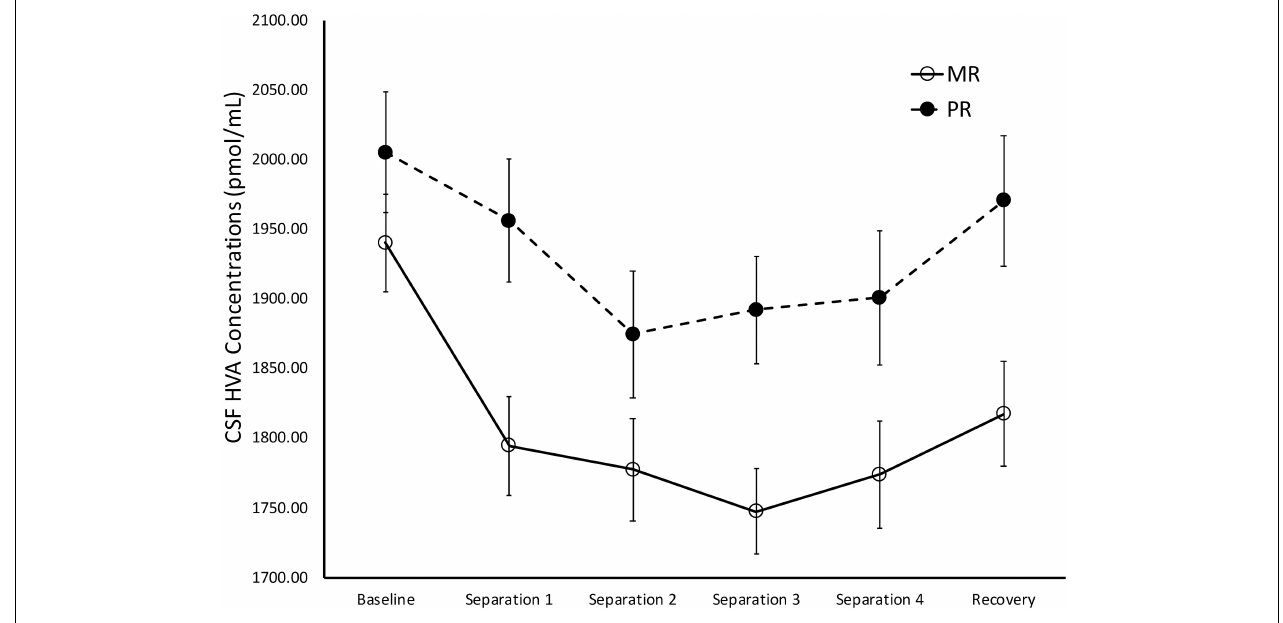
FIGURE 4 | Rearing effects on baseline and stress-induced CSF HVA concentrations. Depicts the relationship between rearing condition and CSF HVA concentrations during Baseline , Separations 1–4 , and Recovery . There was a significant main effect of time on CSF HVA concentrations [ F (1,175) = 5.85, p = 0.02], with CSF HVA concentrations higher at Baseline , when compared to Separations 1–4 or Recovery . There was also a significant main effect of rearing [ F (1,175) = 8.36, p = 0.004], with MR subjects exhibiting lower CSF HVA concentrations at Separations 1–4 and Recovery, when compared to PR subjects. MR subjects are represented by white circles and solid lines, PR subjects are represented by black circles and dashed lines.